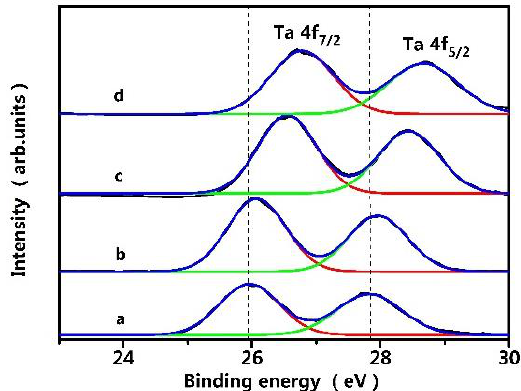
Figure 7. Surface chemistry observation of Ta 2 O 5 samples with thickness of 500 nm; XPS patterns of Ta. ( a ) as-deposited Ta 2 O 5 samples; ( b ) Ta 2 O 5 samples annealed at 573 K; ( c ) Ta 2 O 5 samples annealed at 673 K; and ( d ) Ta 2 O 5 samples annealed at 773 K.